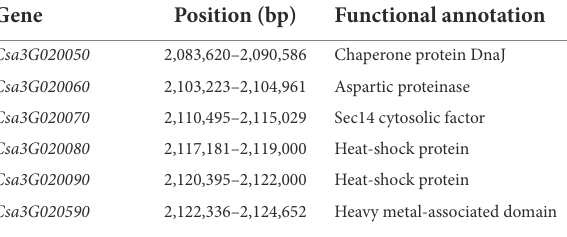
TABLE 1 The six predicted genes in the 38 kb fine mapped interval of gsb3.1 on Chr.3 using the cucumber “9930”_v2 reference genome. Gene Position